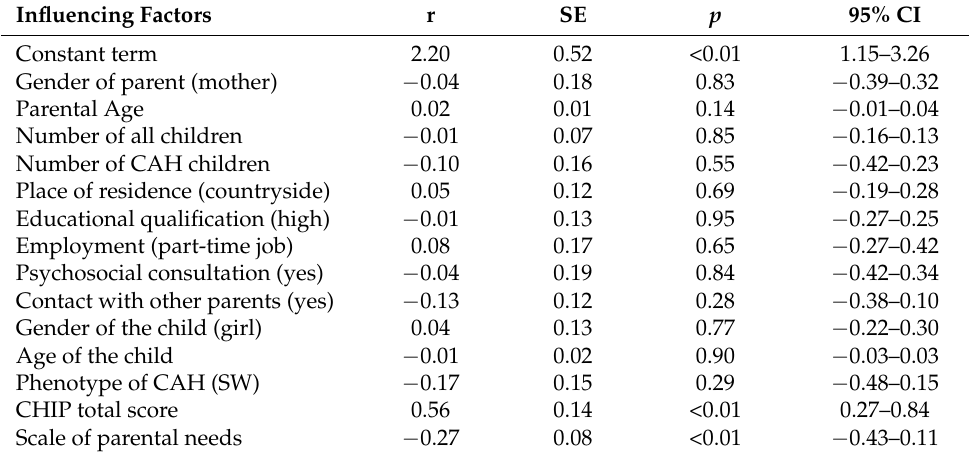
Table 6. Influencing Factors on parental Quality of Life (ULQIE total score).